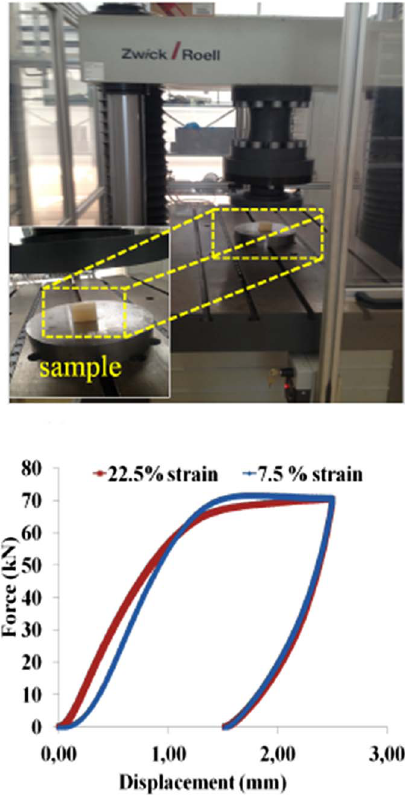
Figure 2. (Top) Photography of the compression machine. (Bottom) Examples of the force-displacement diagrams of the bi-material sample under compressive loading.